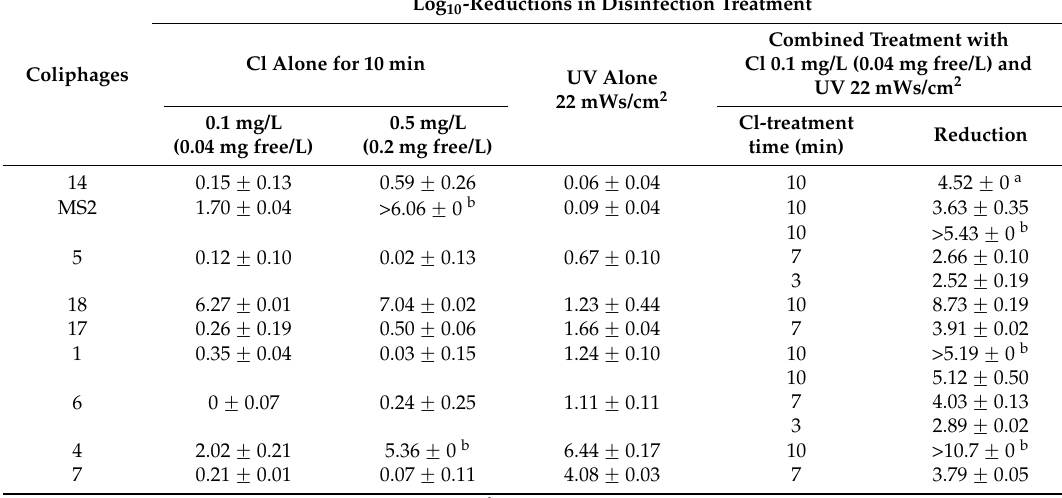
Table 3. The Log 10 -reductions of coliphages during disinfection with Cl alone, UV alone or combined Cl and UV treatment (Mean ˘ SD, n =